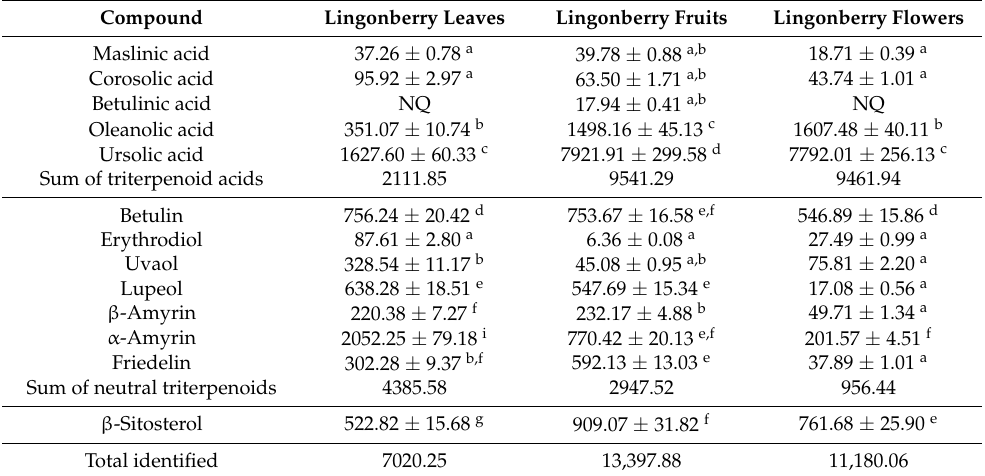
Table 4. Contents of triterpenoids ( µ g/g DW) in extracts of lingonberry leaves, fruits, and